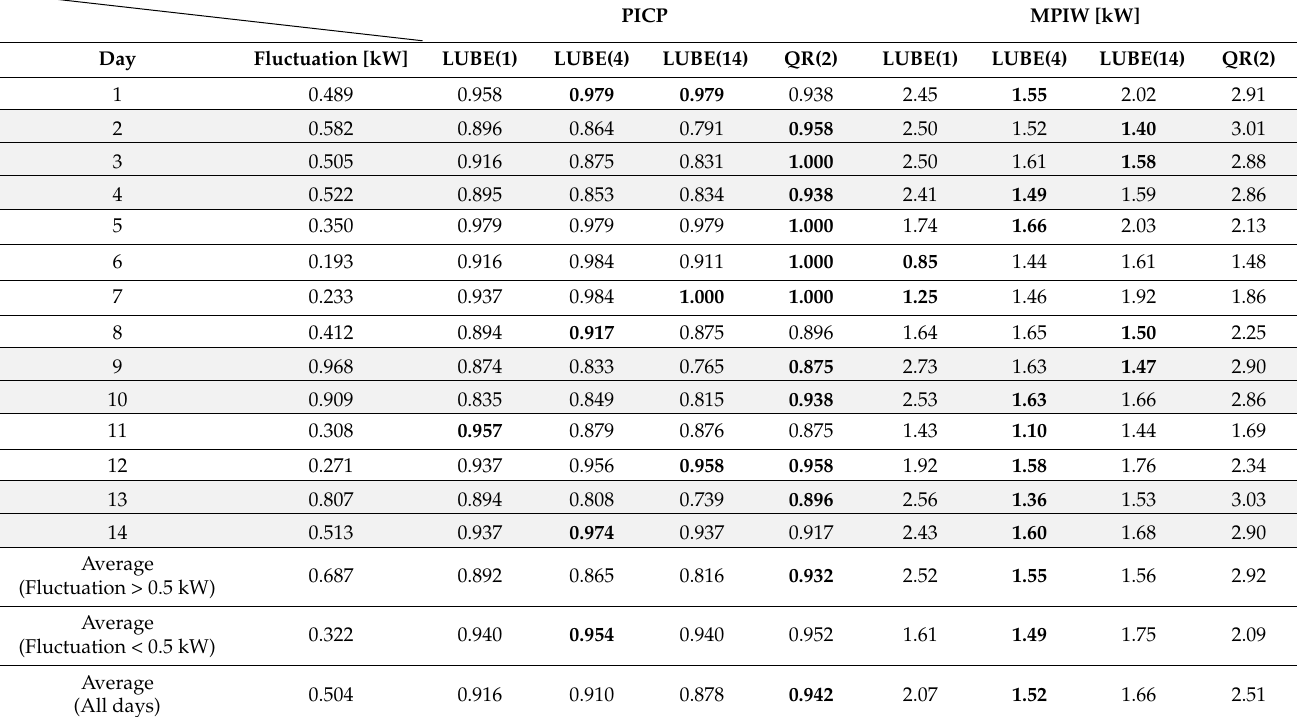
Table 7. Evaluation for LUBE(1), (4), (14) and QR(2) by PICP and MPIW from 1 June to 14 June. PICP MPIW